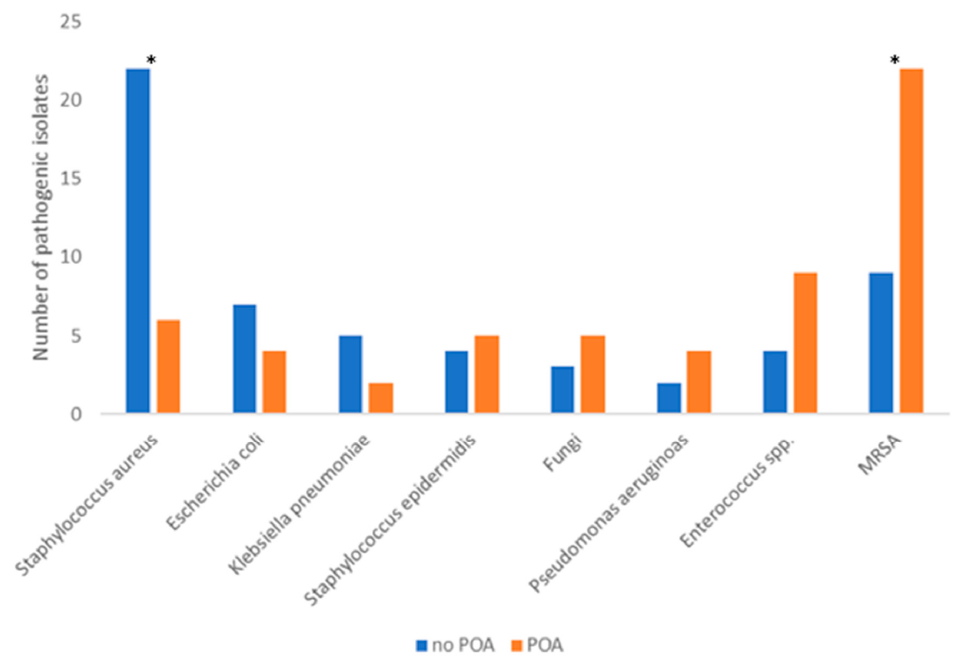
Figure 6. Most common pathogenic isolates. * statistically significant difference as determined by the χ 2 -test.